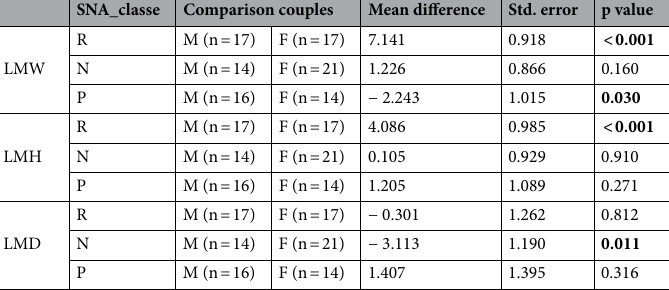
Table 6. Simple main effects: Effect of different maxillary positions (SNA angles) on MS measurements at each level of gender. Significant values are in bold. A p value < 0.05 was considered statistically